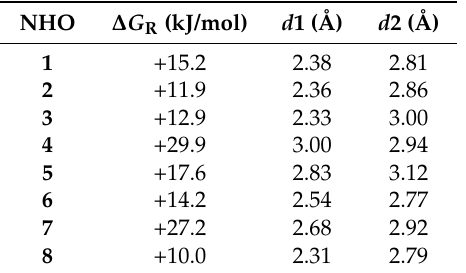
Table 3. Properties of the LiCl(NHO)(THF) 2